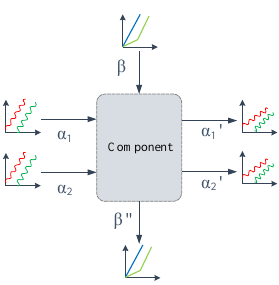
Figure 9. A model consisting of two